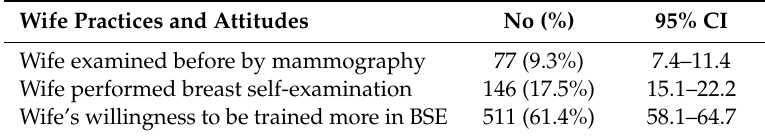
Table 3. Husbands’ knowledge of wife practices and attitudes related to breast